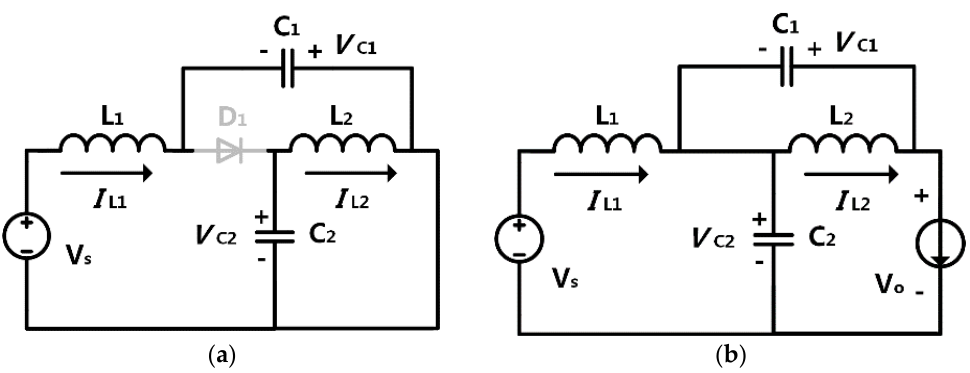
Figure 7. Equivalent circuits of q ‐ Zsource in shoot ‐ through state ( a ) and non ‐ shoot ‐ through state ( b ).